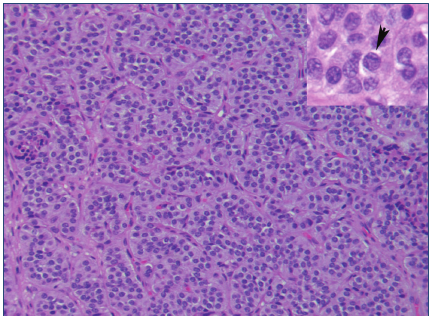
Figure 6: Histology slide from the atypical carcinoid tumor. Nests of uniform, bland carcinoid cells with central nuclei and moderate cytoplasm, prominent vasculature surrounding the nests (H&E, × 20). Inset: infrequent mitoses (H&E, ×